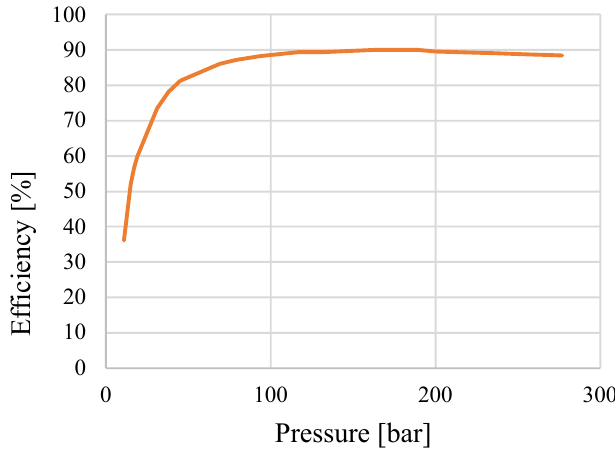
Figure 11. Efficiency curve of the hydraulic motor and hydraulic pump.